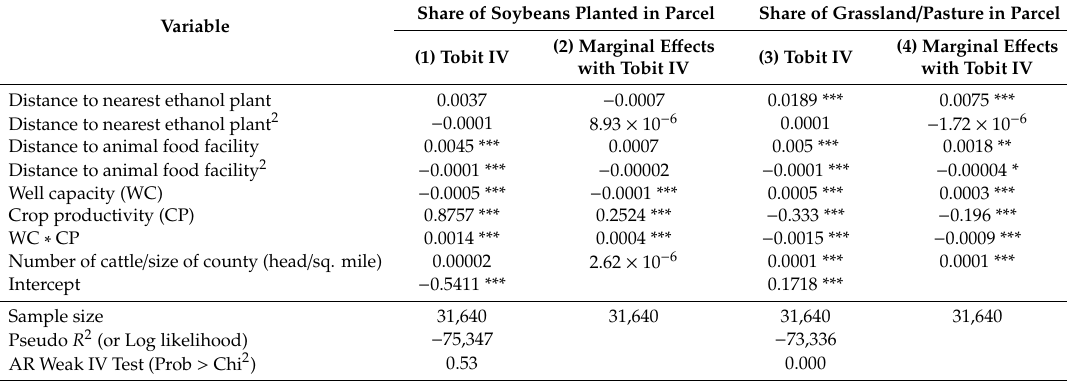
Table 5. Estimates for e ff ects of local markets on soybeans and grassland / pasture. Share of Soybeans Planted in Parcel Share of Grassland / Pasture in Parcel Variable Distance to nearest ethanol